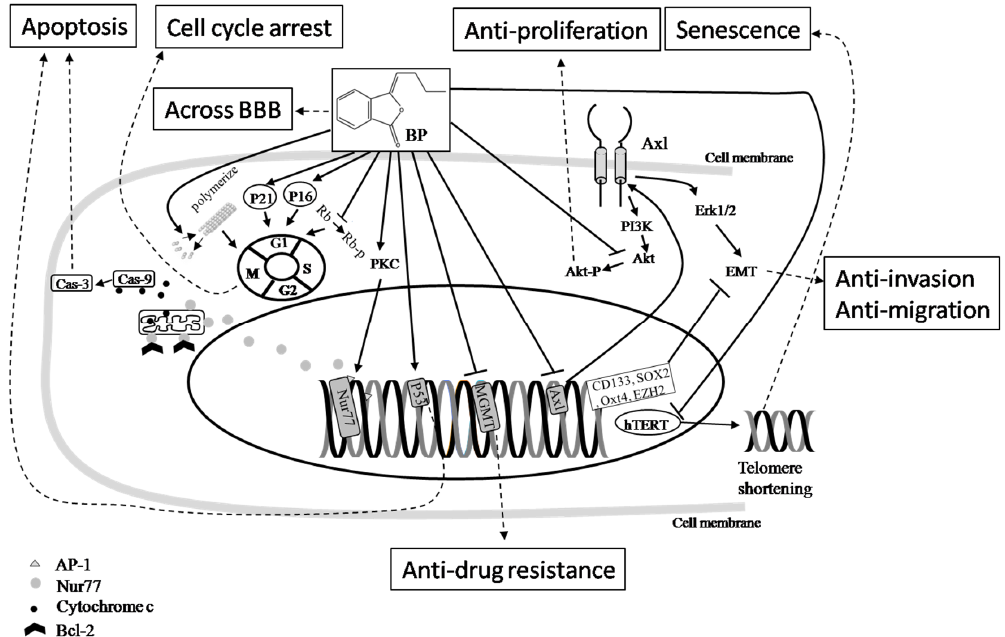
Figure 1. The cancer-fighting mechanisms of BP. The effects of BP in brain cancer therapy include impacts on cancer cell apoptosis, cell cycle arrest, senescence, and telomerase inactivation. The compound also exhibits a relatively high level of penetration through the blood-brain barrier (BBB). Taken together, these impacts and properties have been shown to be anti-proliferative, anti-drug resistance, anti-invasion, anti-migration, and anti-metastatic. Symbol key: Pathway; Inhibition; Final effect. Please see the content in Section 5.1.